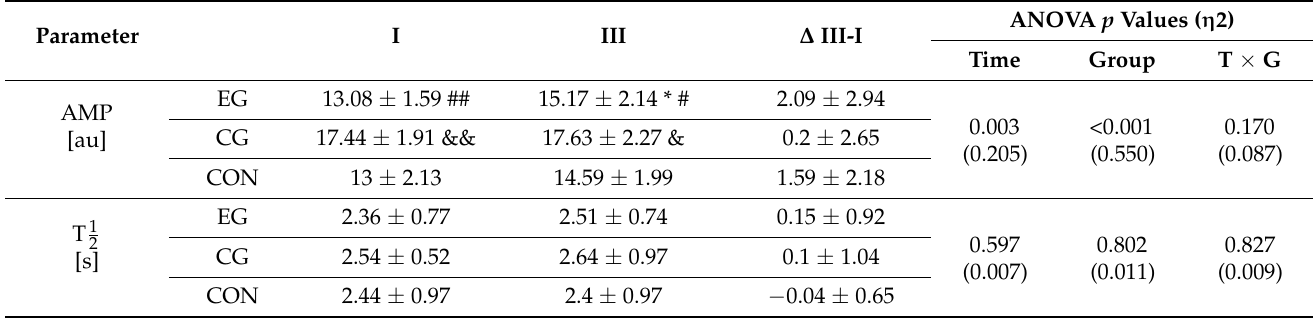
Table 8. Changes in aggregation indices and fibrinogen concentration after 12-week training pro- gram in experimental (EG) and comparison group (CG) and at an interval of 3 months in control group